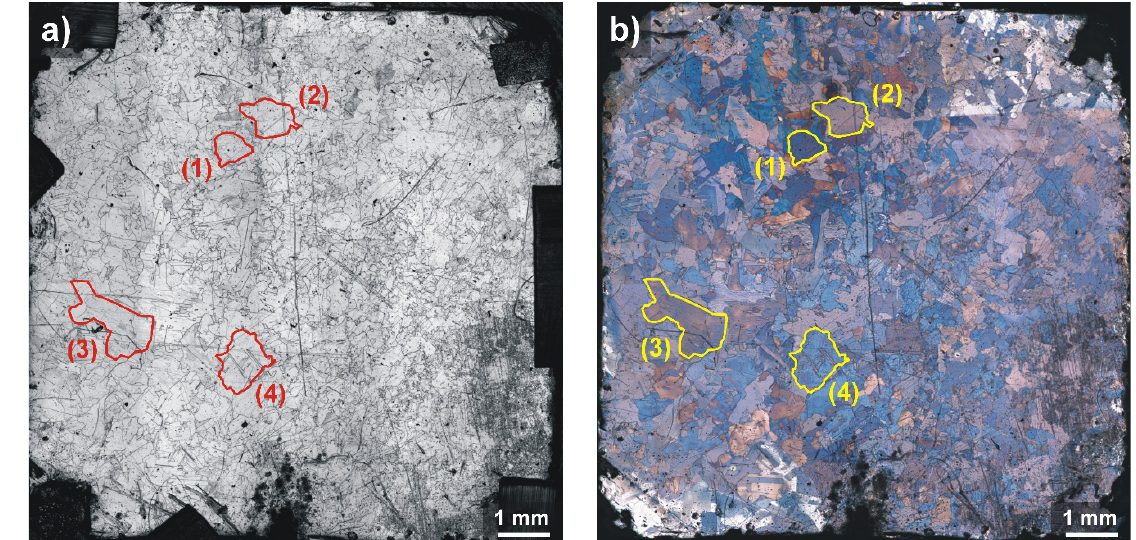
Figure 5. Confocal microscopy image of the polycrystalline surface of the rhodium sample: ( a ) after cleaning, with four marked regions of interest; ( b ) after “high oxidation” in flow-through reactor.